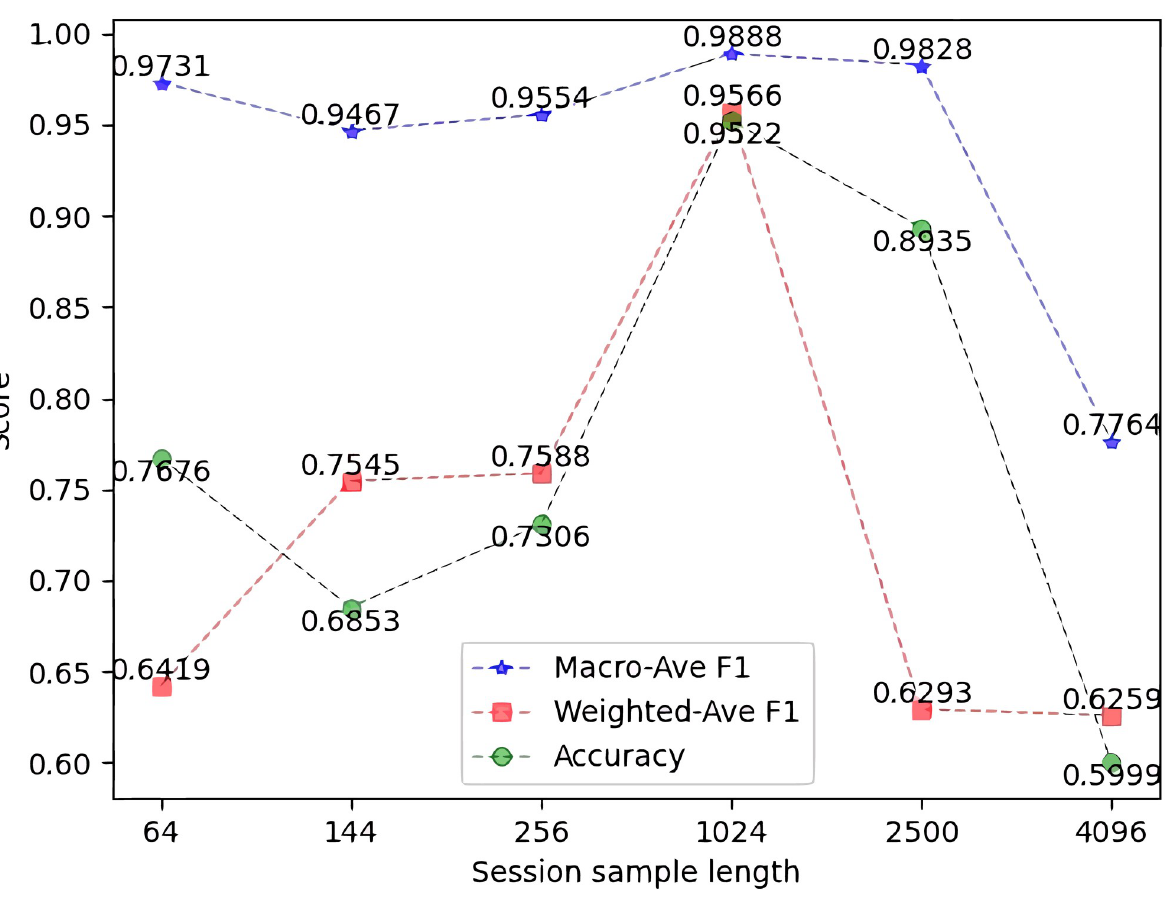
Fig 9. F1-score Macro-Ave, Weighted-Avg, and Accuracy of N